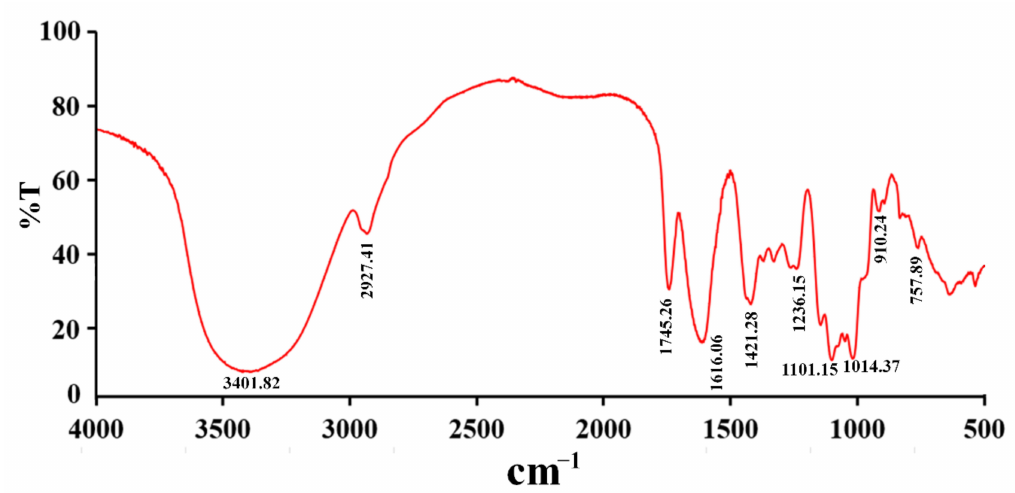
Figure 3. FT-IR spectra of RPP-2a ranging from 400 to 4000 cm − 1 .